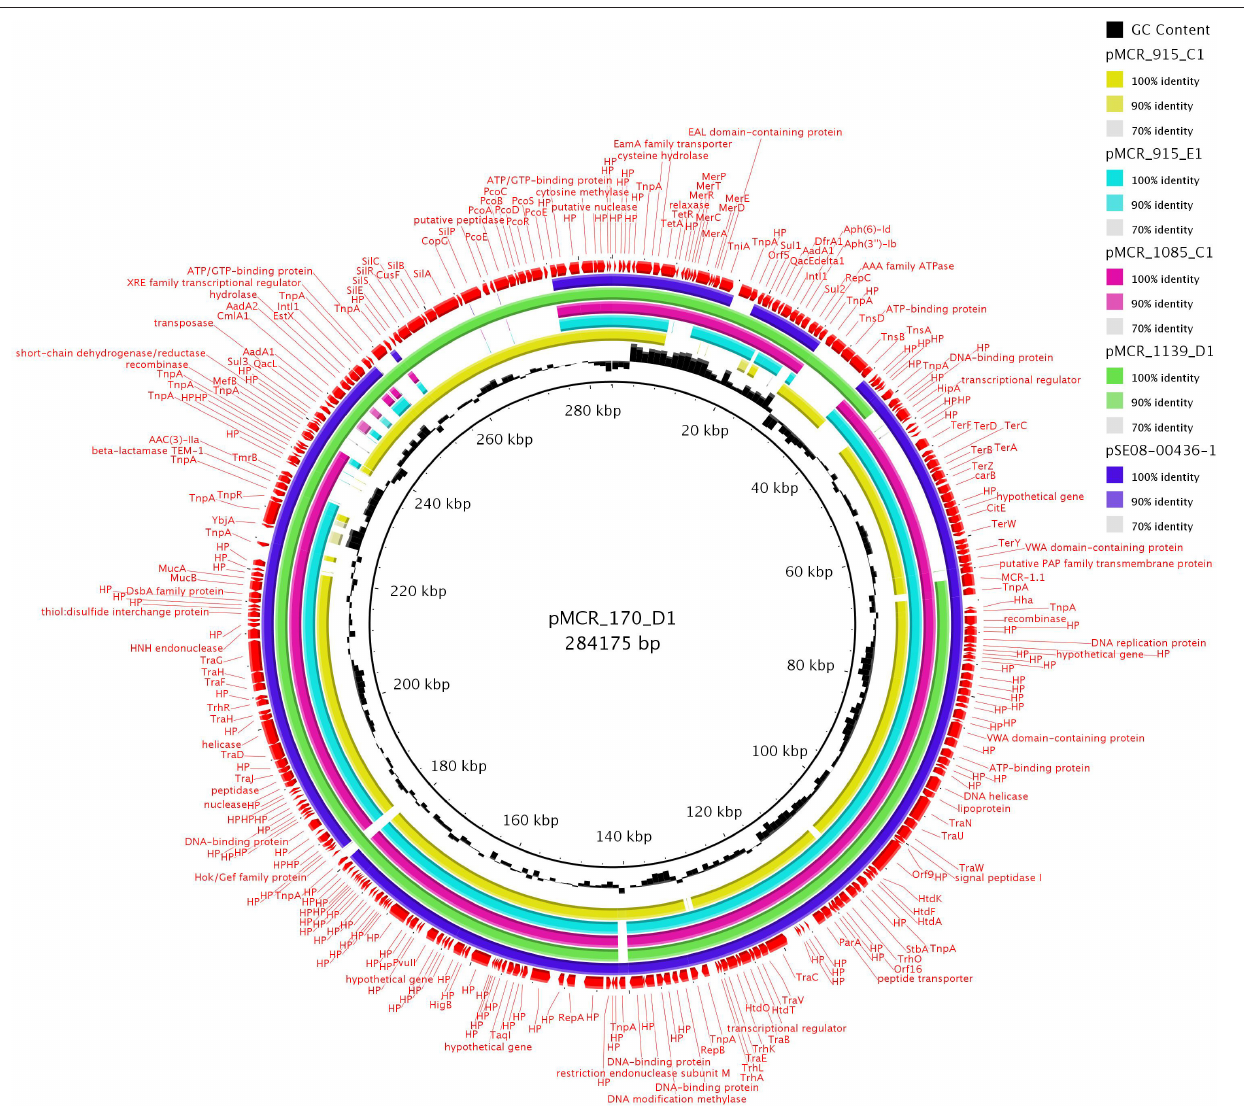
FIGURE 3 | Circular representation of IncHI2 mcr-1 -encoding plasmids. Plasmid pMCR_170_D1 (GenBank accession no. MT929288) was used as a reference for the